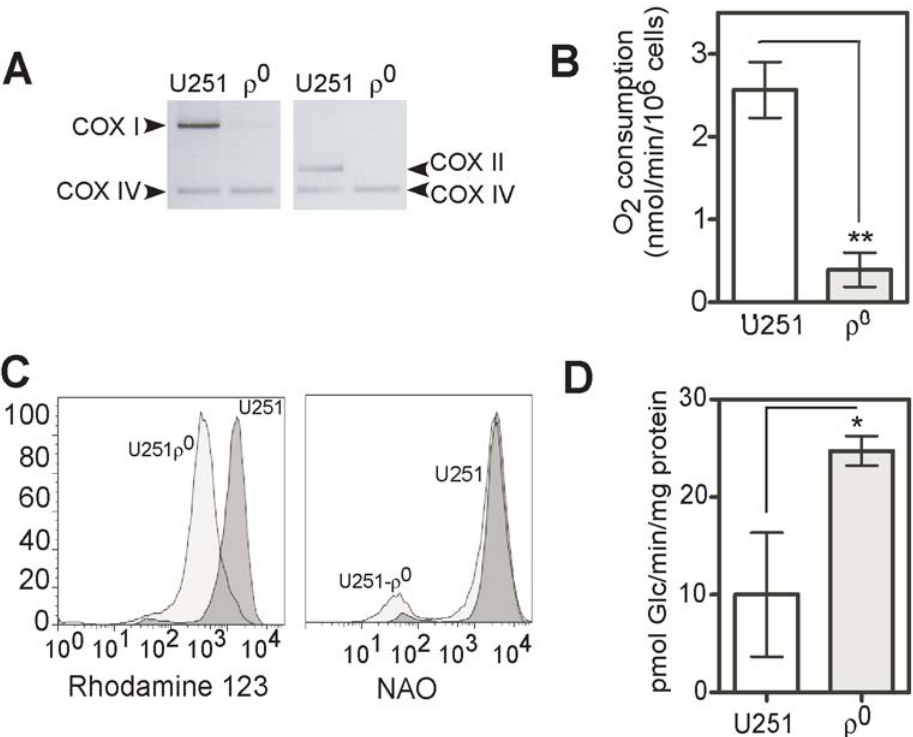
Figure 3. Bioenergetic characterization of mtDNA depleted U251 glioma cells. A ) Genomic DNA was isolated from control and mtDNA- depleted U251 cells, and mtDNA-encoded genes including cytochrome c oxidase subunit I (COX-I) and cytochrome c oxidase subunit II (COX-II) were amplified by PCR. COX IV is used as a nuclear DNA-encoded control. The PCR products were electrophoresed on 1.5% agarose gel and then visualized by EtBr staining. A representative result of three independent experiments is shown. B) Average oxygen consumption rates in U251 and U251 r 0 . Results are given as means 6 SD of 5 separate experiments. C) Rhodamine123 fluorescence profiles of U251 and U251 r 0 ; NAO fluorescent profiles of U251 and U251 r 0 . D) Glucose transport activity for the parental and r 0 cells. Results are given as means 6 SD of 3 separate